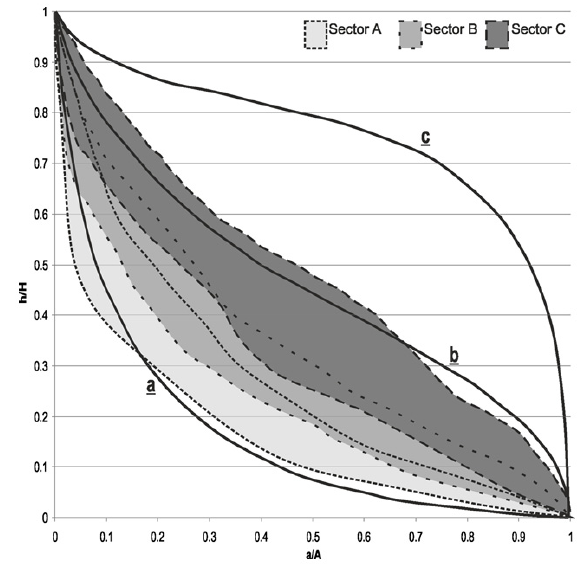
Figure 6. Envelope of the hypsographic curves of the Somma-Vesu- vius river basins for the A, B and C sectors and classification ac- cording to Strahler [1957]: a = old stage; b = mature stage; c = young stage. (Figure 6). The hypsographic curves analysis of the Somma-Vesuvius sector B shows on the contrary an ir- regular trend with many concavity/convexity variations (between mature and old stage). The curves relative to the basins of sector C confirm an upwards concave trend, similar to those of the N sector but with an index of maturity closer to mature stage (line b in Figure 6). The topographical profiles of the basins nos. 15, 24 and 29 clearly show the morphological diversity relative to the three sectors A, B and C (Figure 7). In detail, it is possible to individuate the buried morphological im- print of the Somma caldera old rim (cS), located down- hill compared to the base level of Vesuvius cone (bV), with an elevation higher than 800 m a.s.l. (Figure 7).